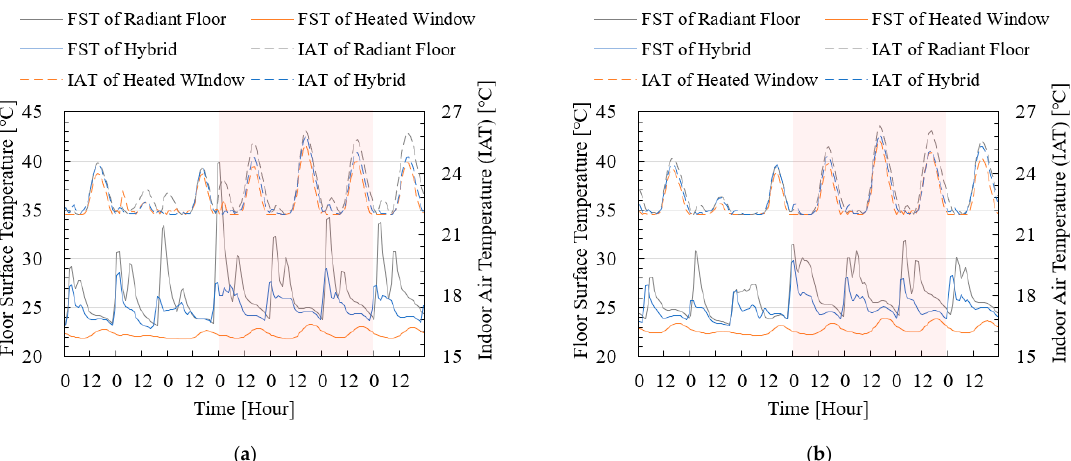
Figure 11. Each model’s floor surface temperature (FST) and the indoor air temperature (IAT) of each model. ( a ) Ground Floor; ( b ) Typical Floor.